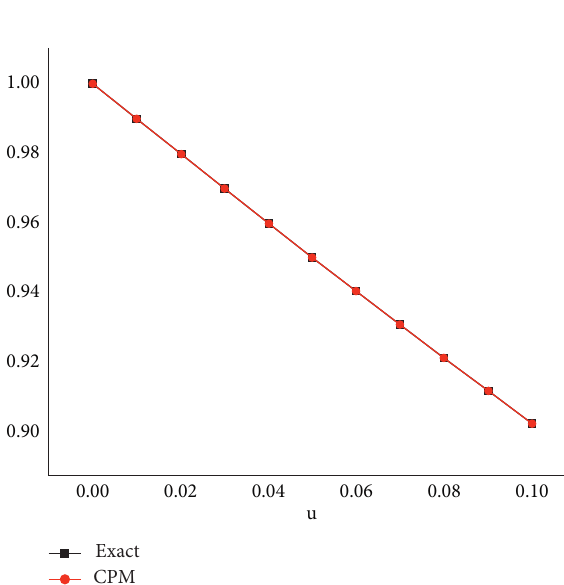
Figure 11: The exact and CPM solution graph for problem 5.